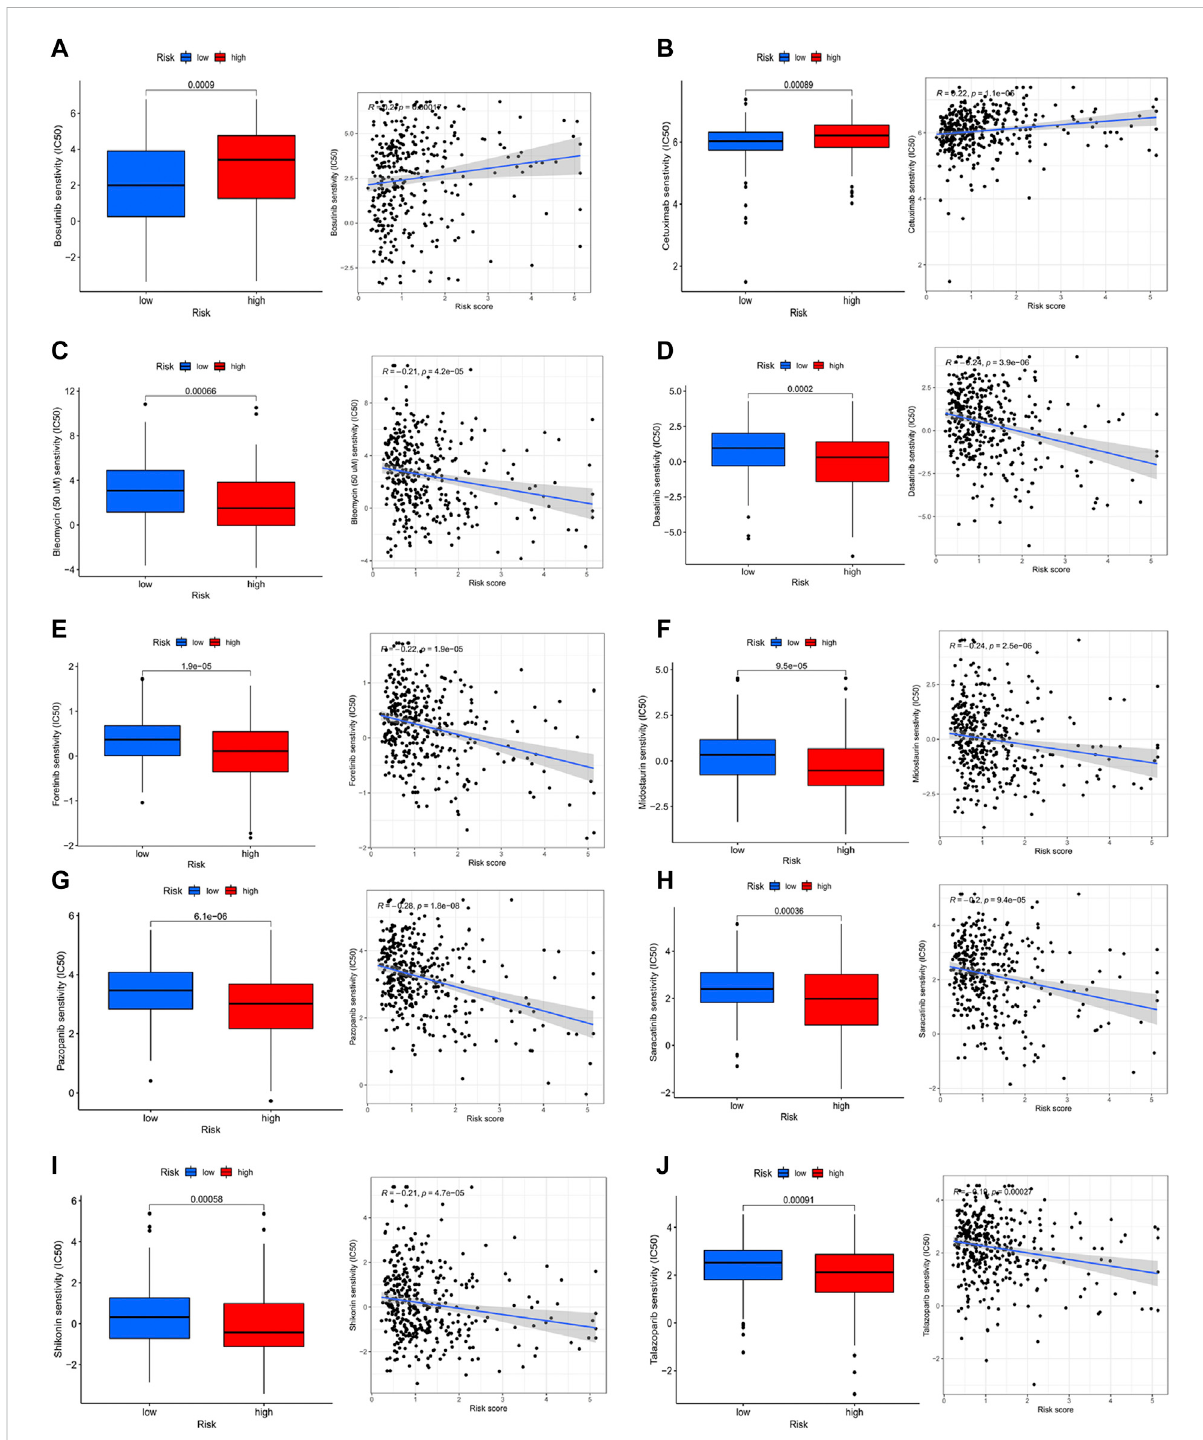
FIGURE 9 Analysis of drug sensitivity. (A-j) bosutinib; cetuximab; bleomycin (50 uM); dasatinib; foretinib; midostaurin; pazopanib; saracatinib; shikonin;